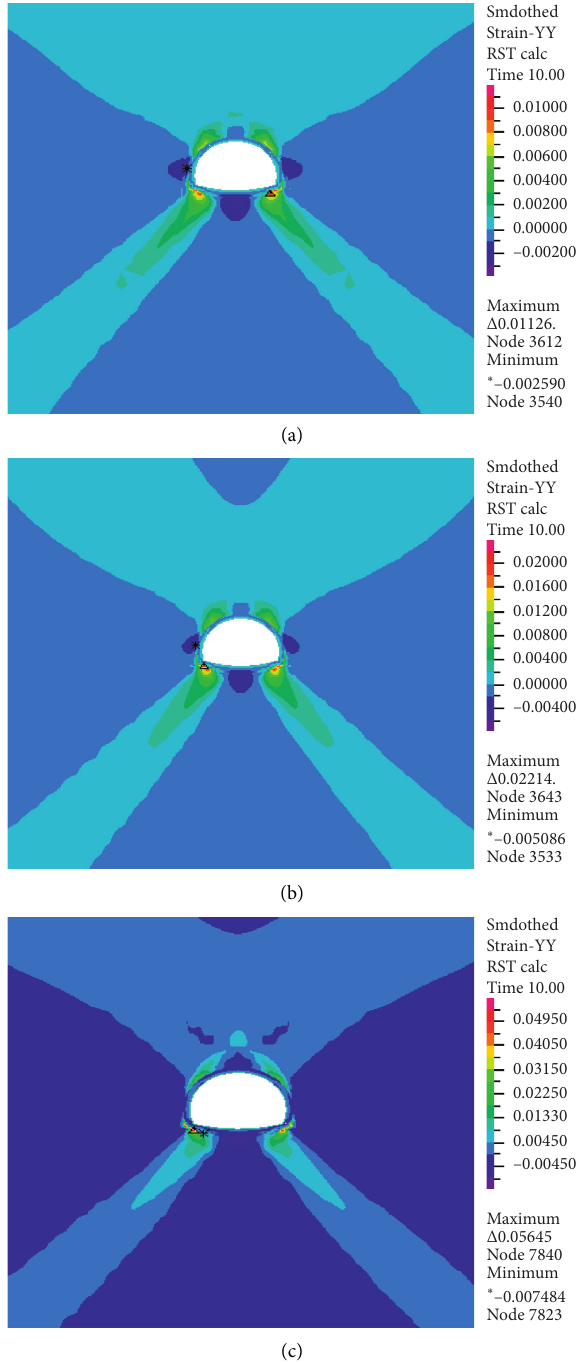
Figure 8: Plastic strain nephograms of the loess mass surrounding the tunnel for different overburden thicknesses: (a) 30m, η � 2.265; (b) 60m, η � 2.266; (c) 80 m, η �